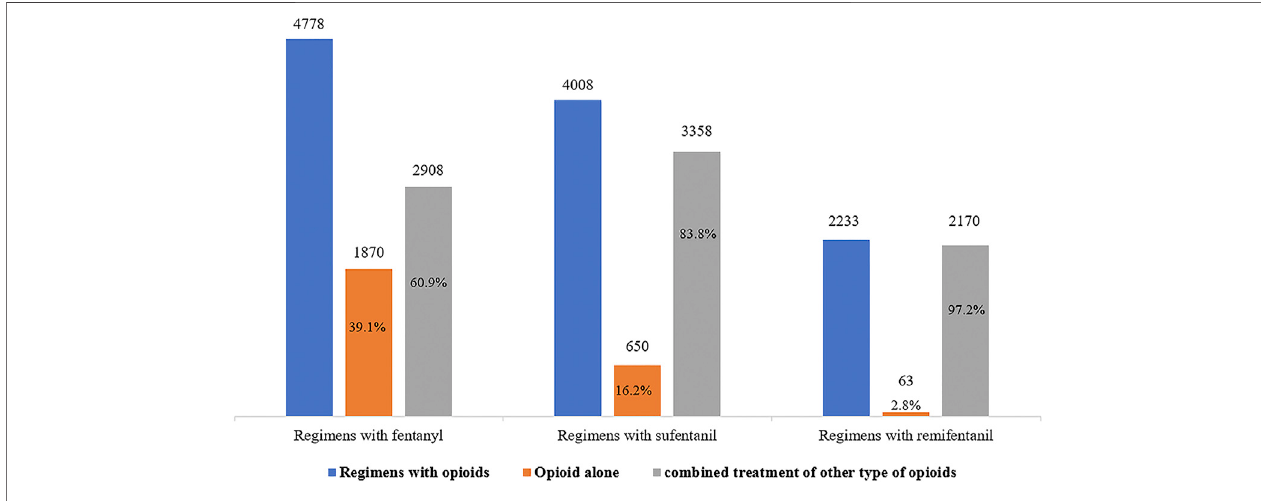
FIGURE 2 | Treatment of opioids during ICU stay.